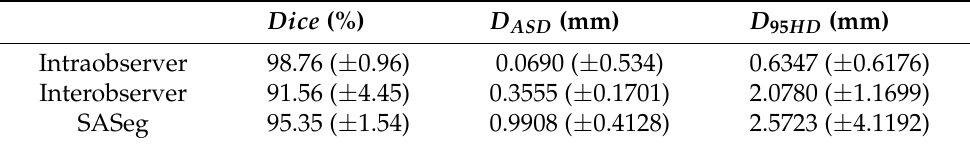
Table 4. Intra- and interobserver reliabilities and agreement of manual segmentation by the first expert.